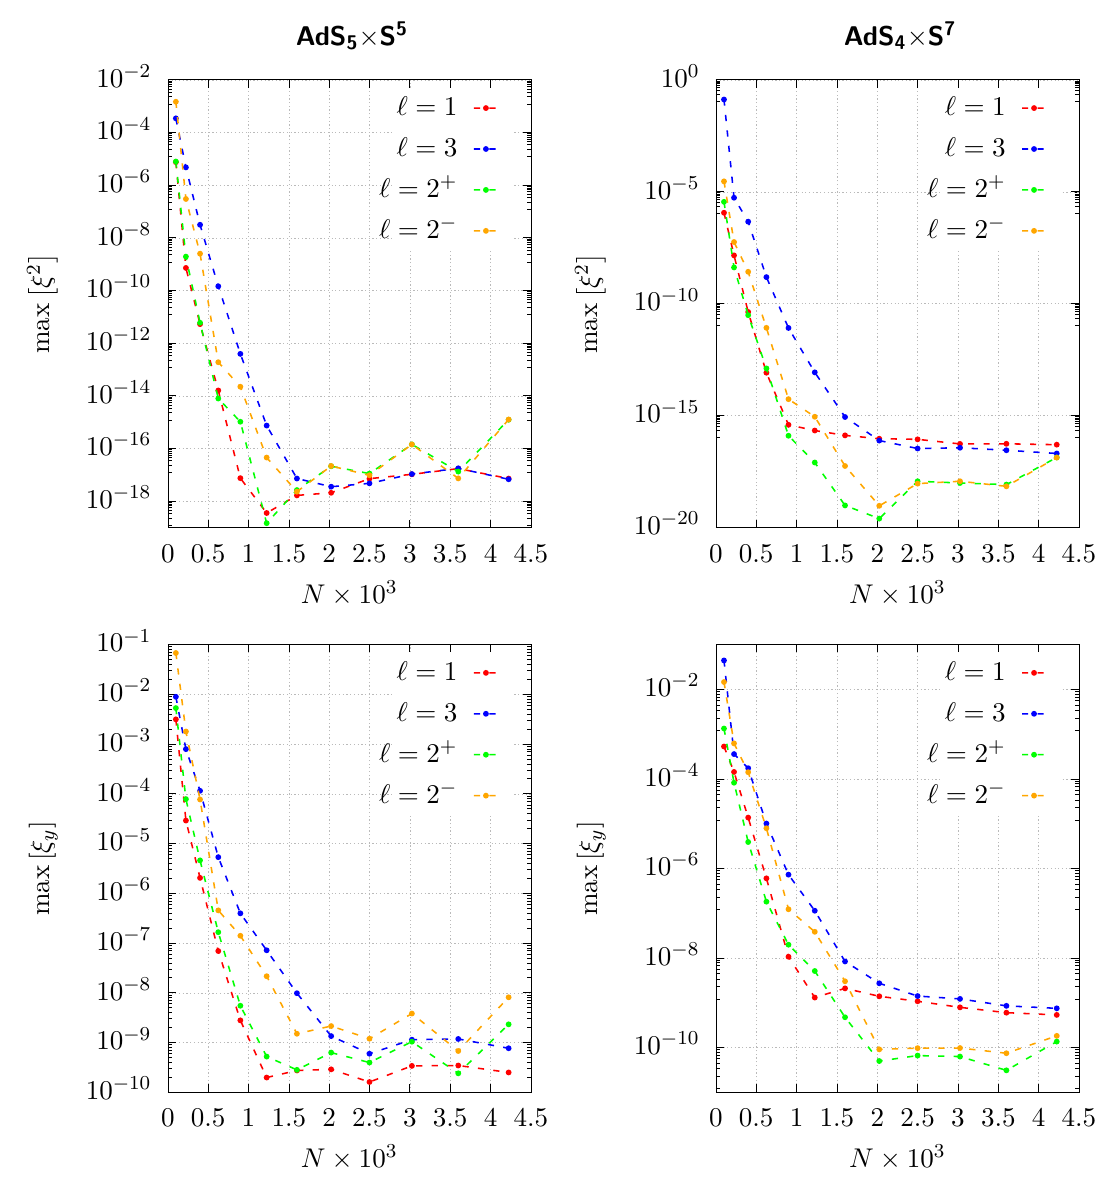
Figure 19. Logarithmic plot of the maximum values of ξ 2 and ξ y on the whole integration domain, as a function of the grid size. In both cases the error decays exponentially, as expected. The plot for the DeTurck vector component along the x -direction is very similar to that for the y -component, so we do not include it